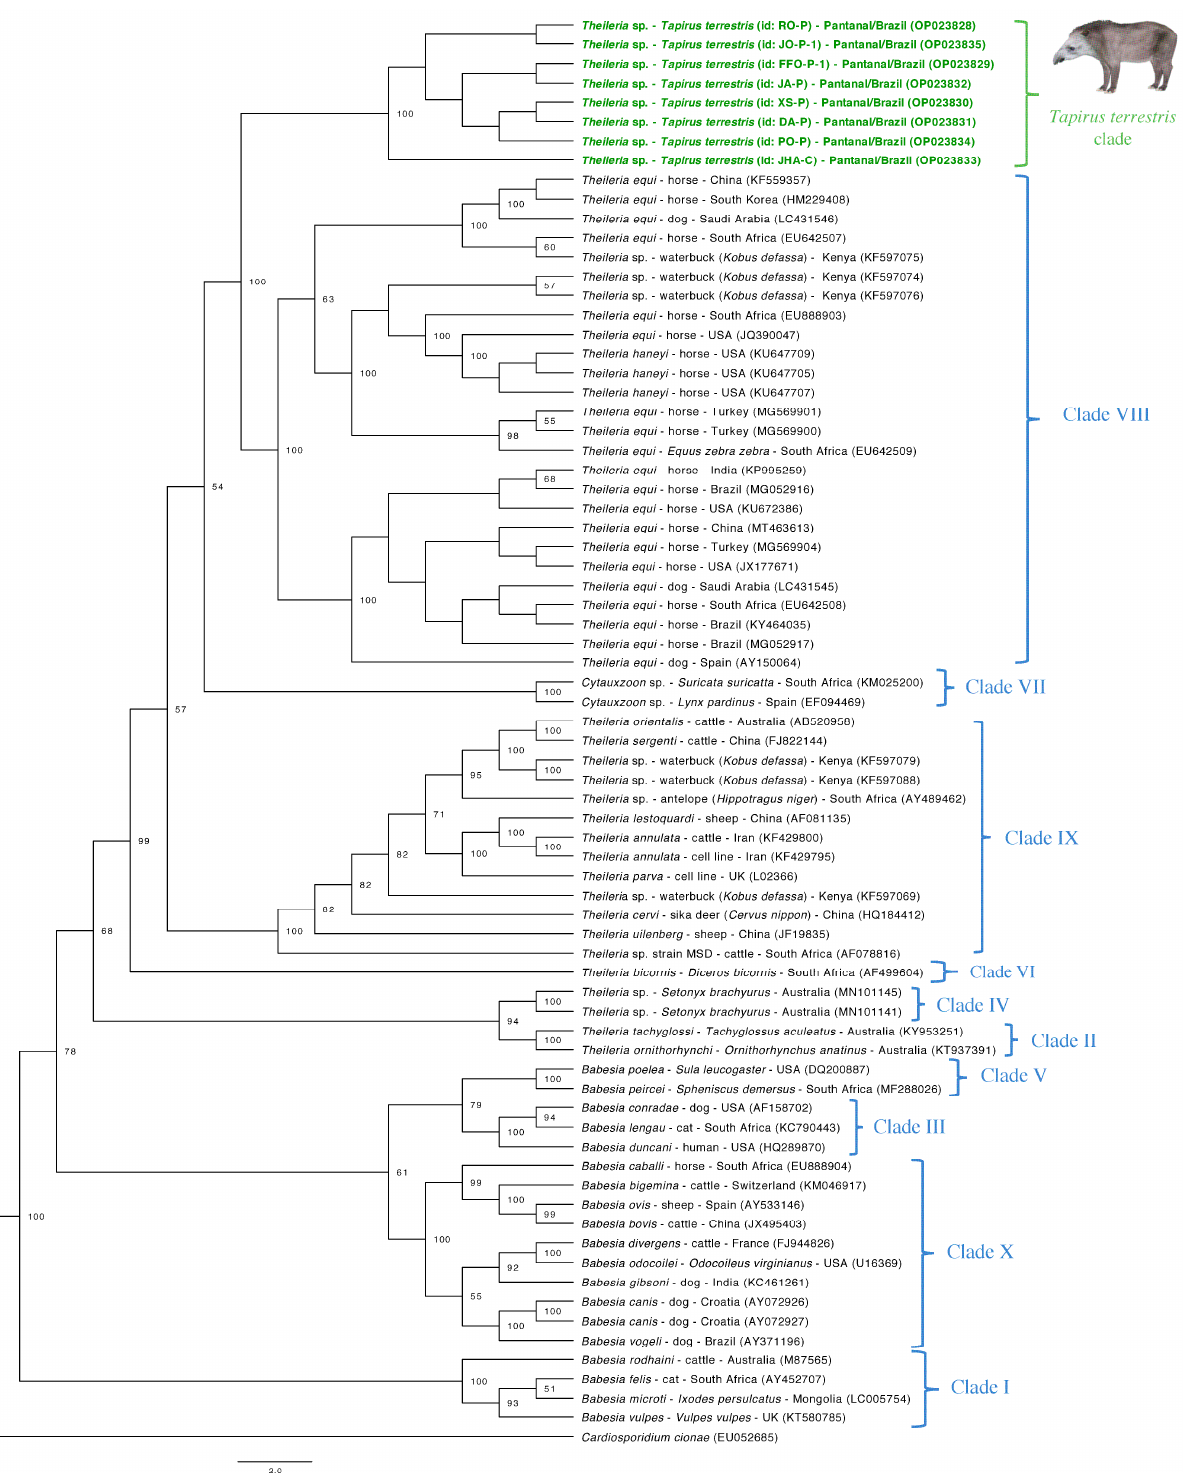
Figure 2. Phylogenetic tree based on the 18S rRNA gene from Piroplasmida. Tree was constructed by Bayesian inference using an alignment size of 1460 bp. Clades (I–X) were identified according to the phylogenetic study of Piroplasmida conducted by Jalovecka et al. (2019). Sequences from the present study are highlighted in green. Post probability values >50 appear in tree. Identifications of the phylogenetic groups as proposed by Jalovecka et al. (2019) are indicated next to taxa or